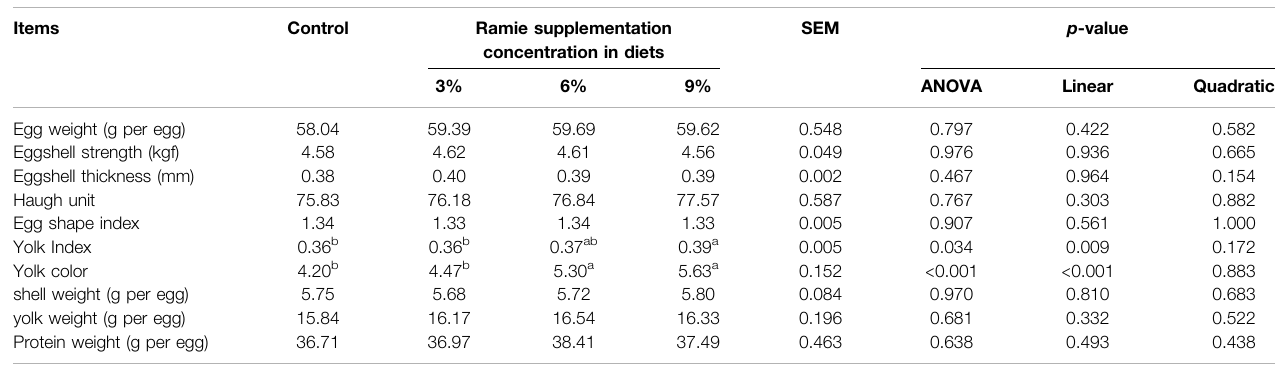
TABLE 3 | Effects of dietary ramie supplementation on the egg quality of laying hens. Items